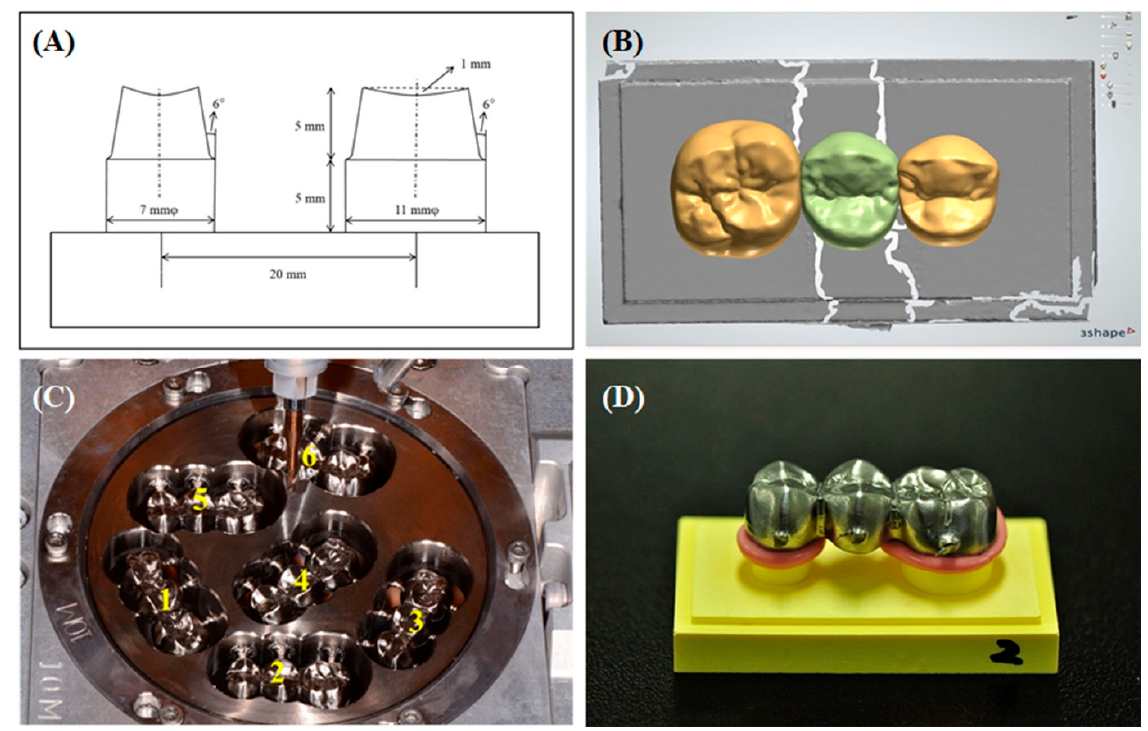
Figure 1 . ( A ) Design of standard three ‐ unit fixed dental prostheses (FDP), ( B ) designed FDP, and Figure 1. ( A ) Design of standard three-unit fixed dental prostheses (FDP), ( B ) designed FDP, and ( C ) sequentially milled ( C ) sequentially milled Ti FDP on Computer Aided Design/Computer Aided Manufacturing Ti FDP on Computer Aided Design/Computer Aided Manufacturing (CAD/CAM). The numbers indicate the milling (CAD/CAM). The numbers indicate the milling sequence. ( D ) Seated on FDP die with light ‐ body sequence. ( D ) Seated on FDP die with light-body silicone.